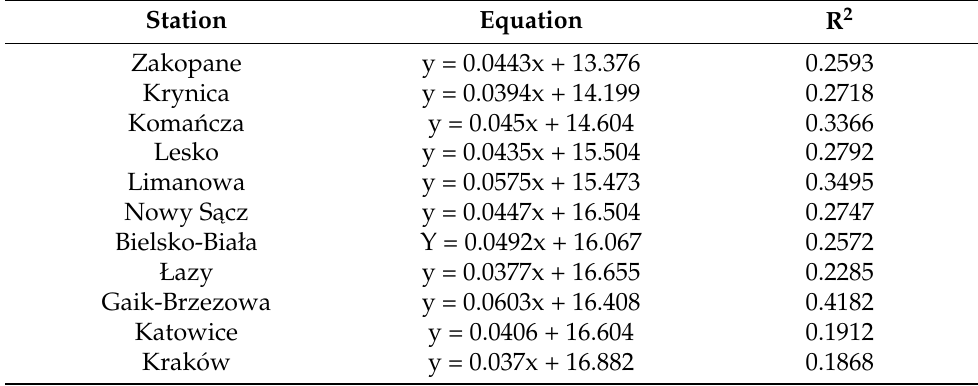
Table A4. Linear regressin equations and the values of R 2 for the series of